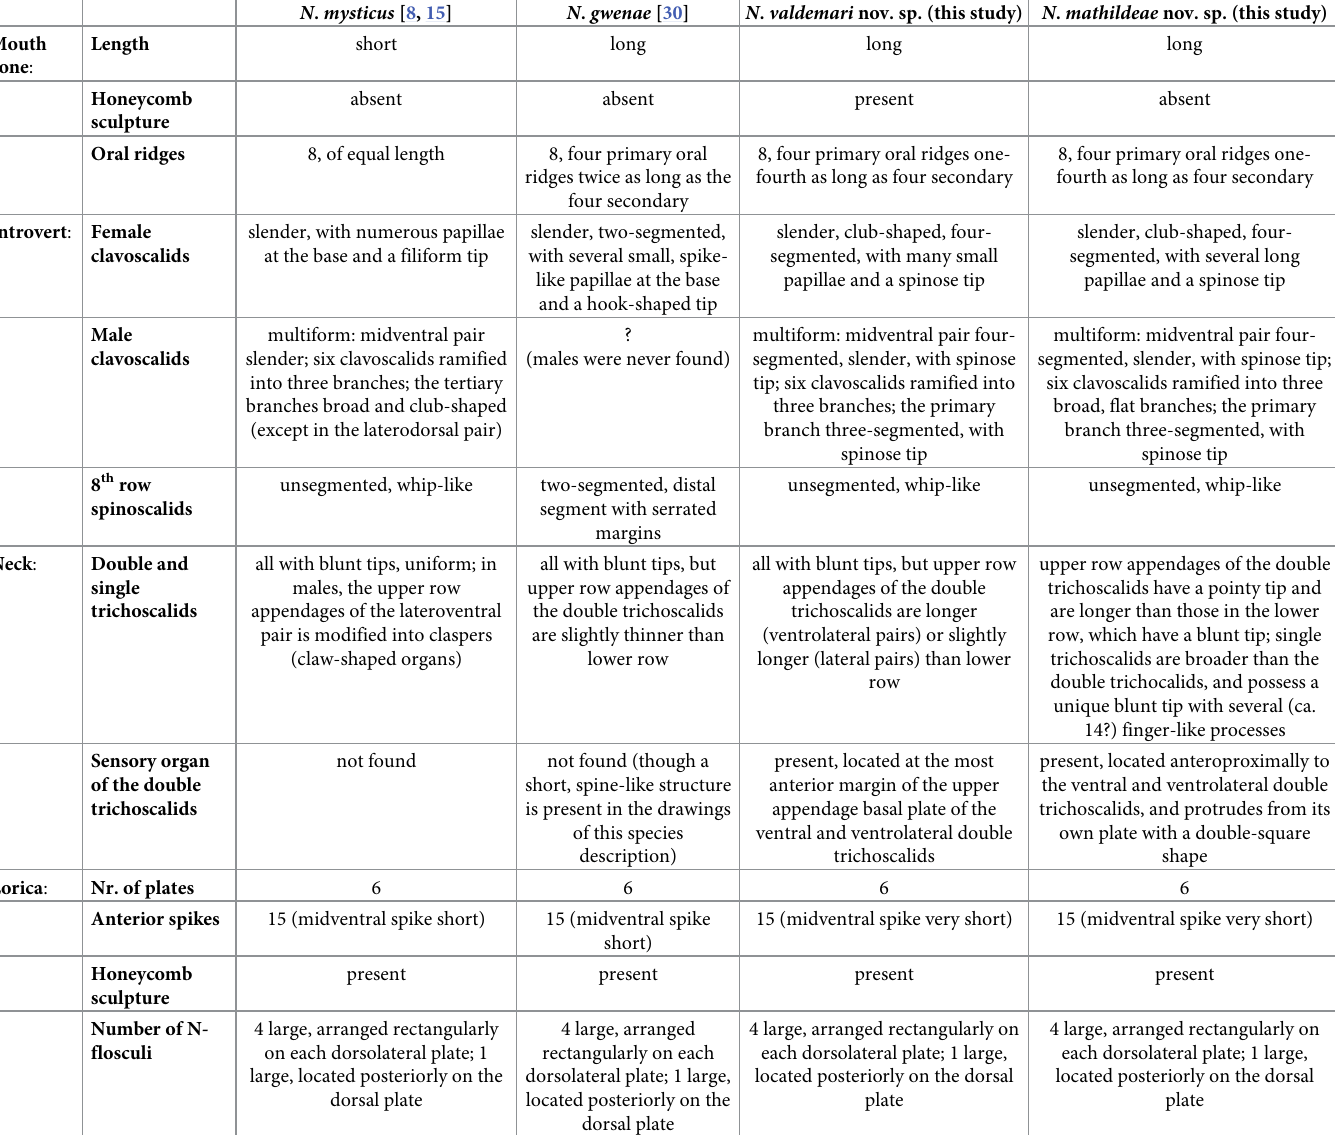
Table 1. Comparison of adult characters of the species assigned to the genus Nanaloricus (family Nanaloricidae). Nanaloricus khaitatus is not included in this table because its original description is probably based on observations of at least three different